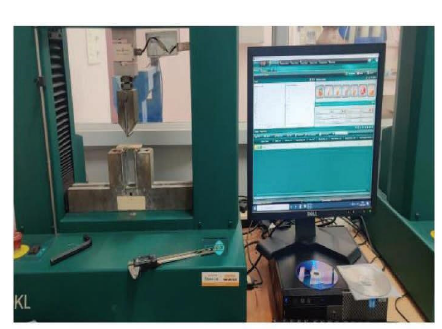
Figure 6: Flexural test.